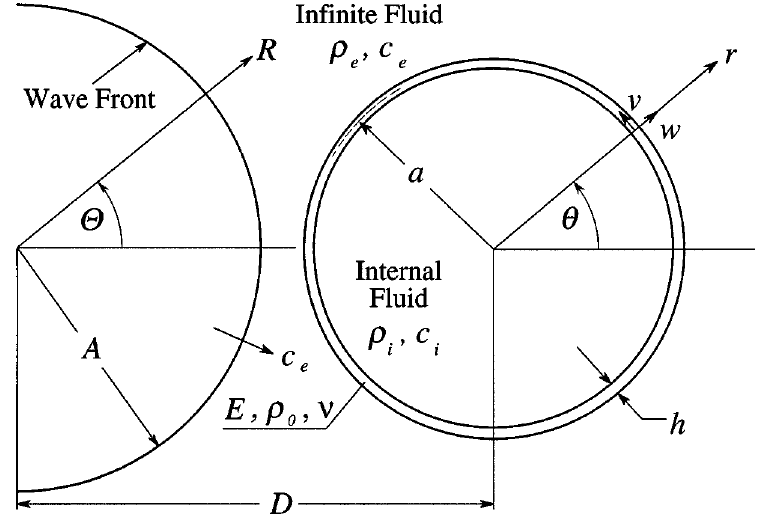
Fig. 1. Schematic of shell geometry and incident spherical wave with associated